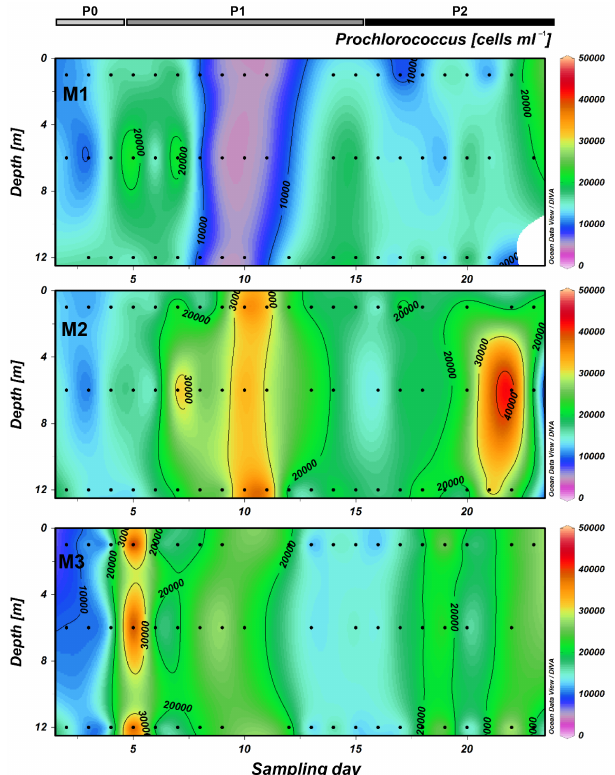
Figure 6. Picoeukaryotes incellsmL − 1 at each of the three depths (1, 6 and 12m) inside each mesocosm (M1, M2 and